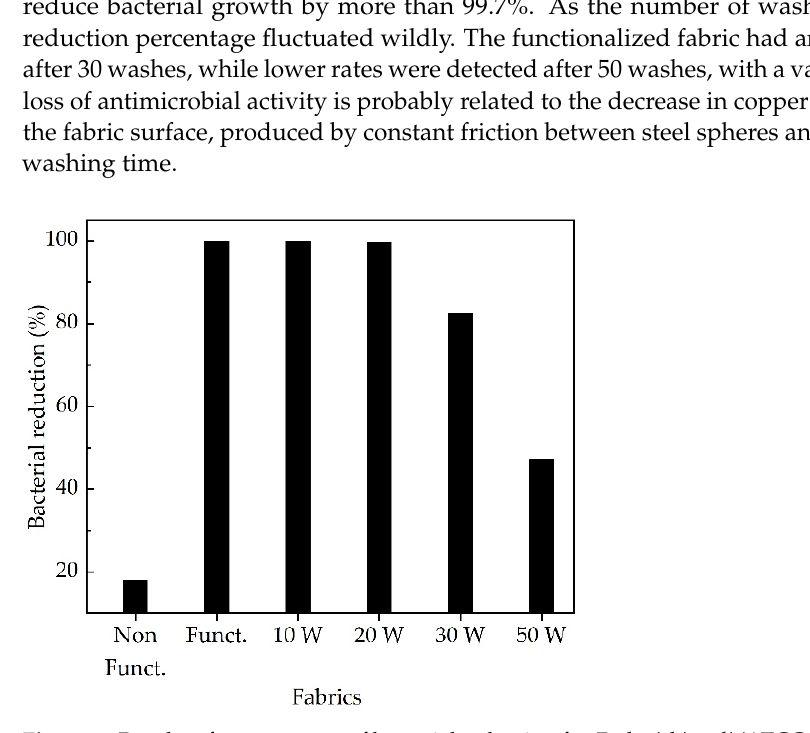
Figure 7. Scheme of the antibacterial and antiviral activity of the PES/CO fabric functionalized with copper oxides.